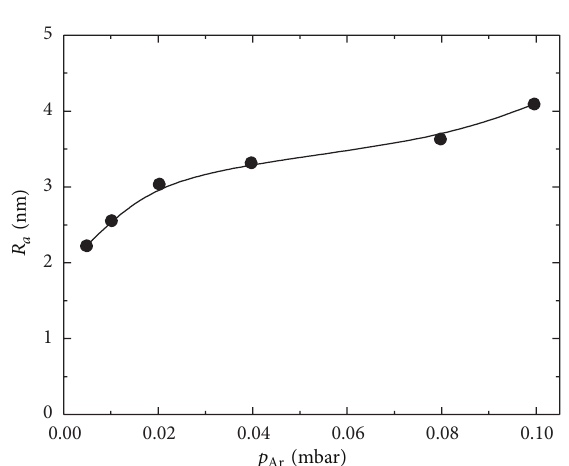
Figure 4: Influence of sputtering pressure on the surface roughness of the as-obtained Pd films.